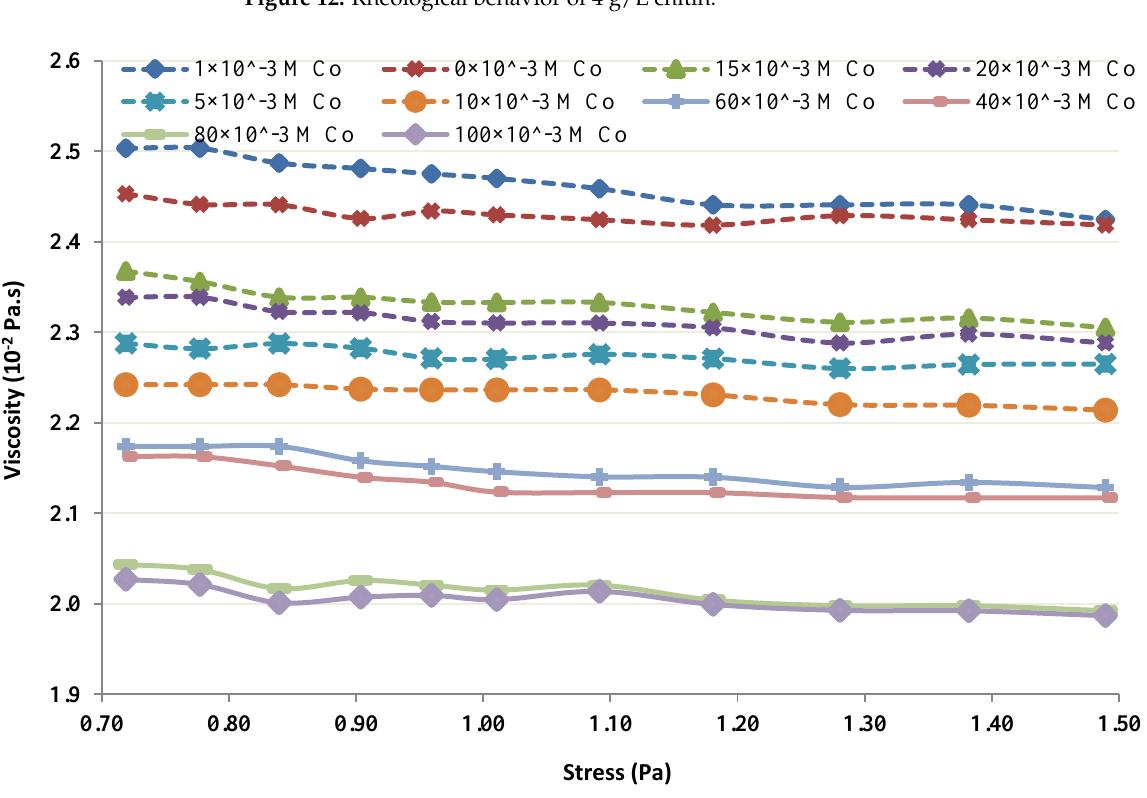
Figure 13. Rheological behavior of 12 g/L